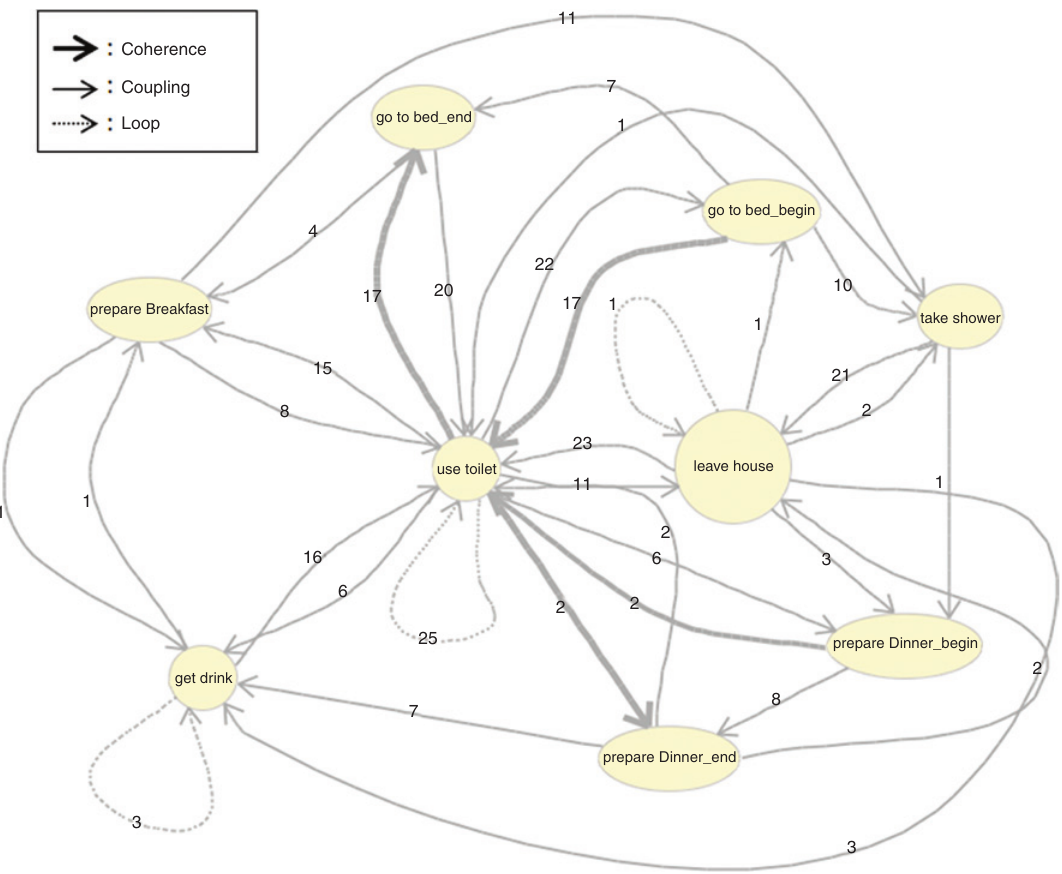
Figure 6: Understanding Model of the Experiment Represented by a